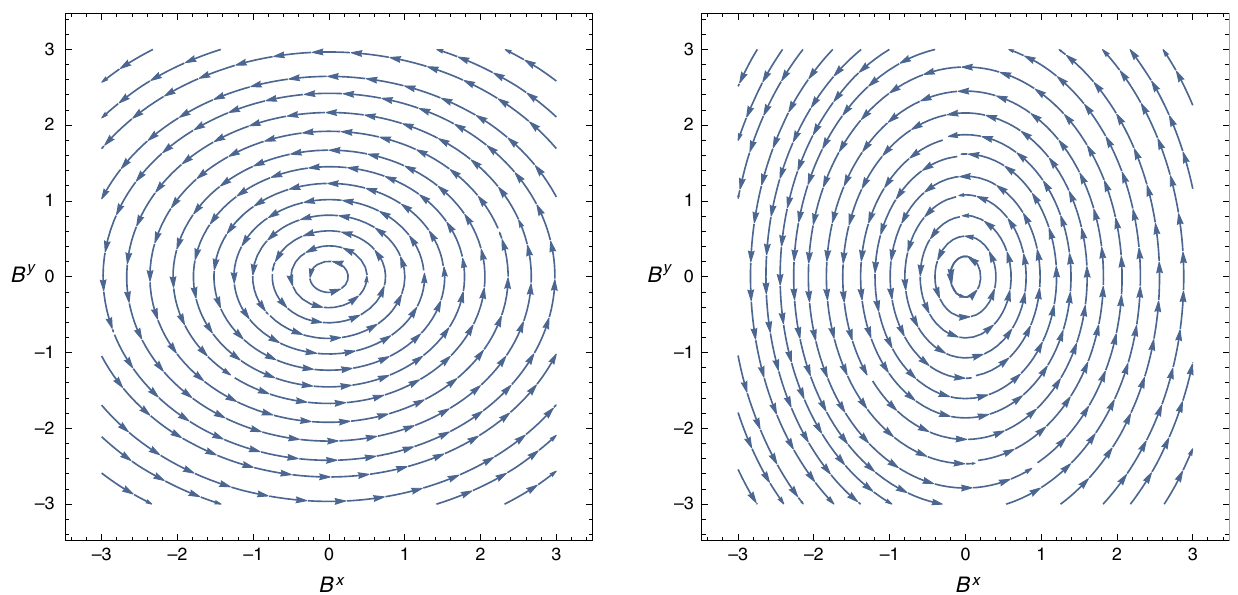
Fig. 3 These vector plots illustrate the changes of the magnetic field lines on the ( x , y ) plane which follow the GW ( + ) mode. The two patterns are separated in time by τ/ 2, where τ is the period. The GW parameters are a = 0 . 312, w/ 2 π = 26 . 80 Hz. We have used Eqs. (3.48) and (3.49), with I = 4 . 6 A